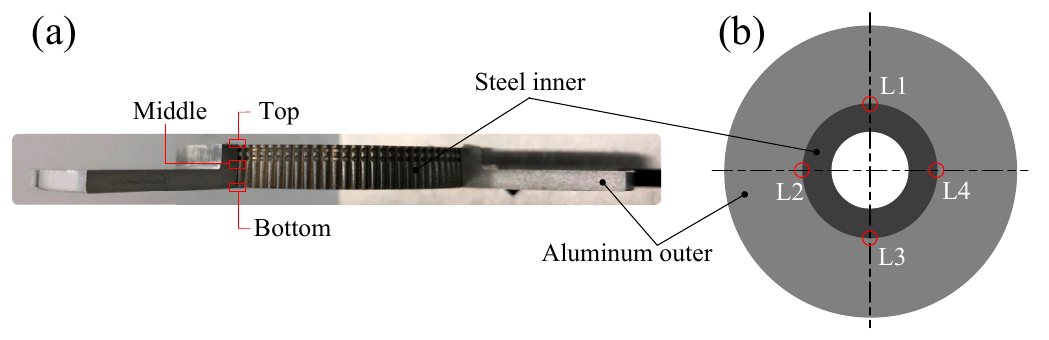
Figure 13. Fabricated specimen: ( a ) joined specimen; ( b ) measured points.